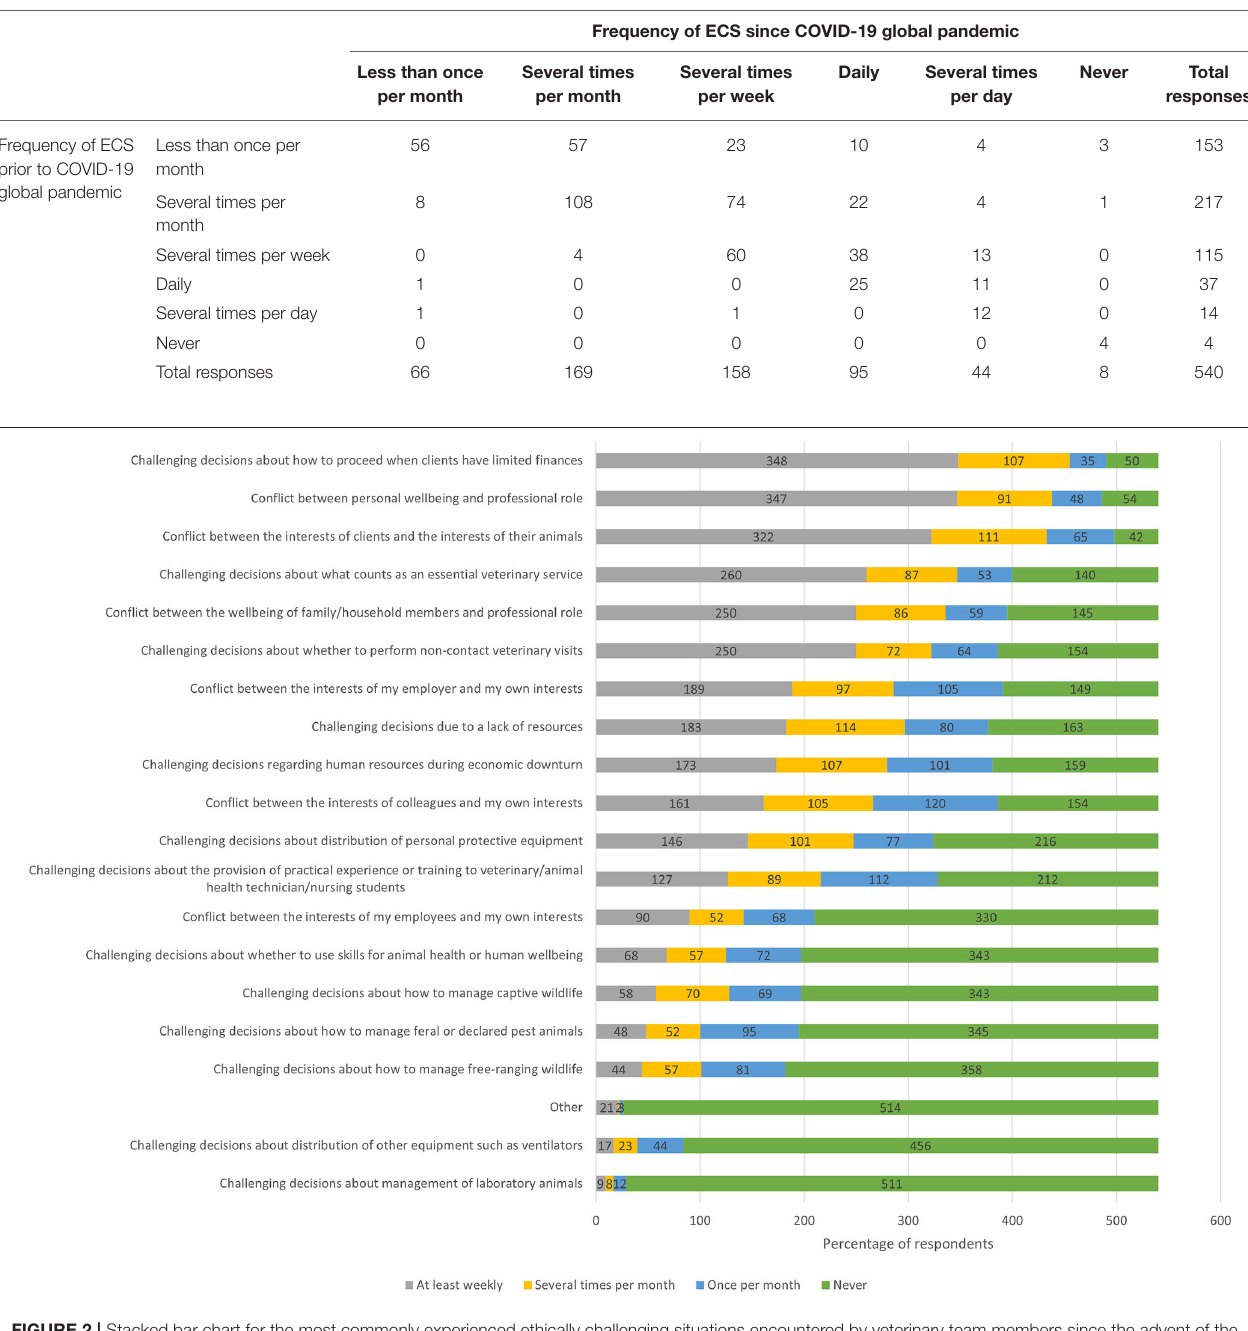
TABLE 2 | Comparison of frequency of ethically challenging situations (ECS) encountered by veterinarians, animal health technicians and veterinary nurses prior to and since the advent of the COVID-19 global pandemic ( n =